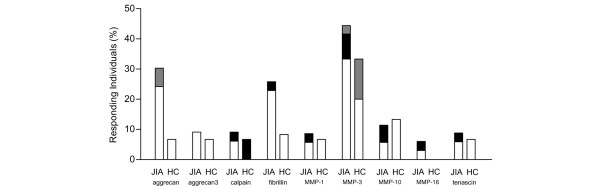
Percentage of patients with juvenile idiopathic arthritis (JIA) and healthy controls showing positive T-cell proliferative responses. Transparent bar: 2 ≤ stimulation index (SI) < 3; black bar: 3 ≤ SI < 4; gray bar: SI ≥ 4. The highest frequencies were found for the peptides derived from aggrecan, fibrillin, and matrix metalloproteinase (MMP)-3.